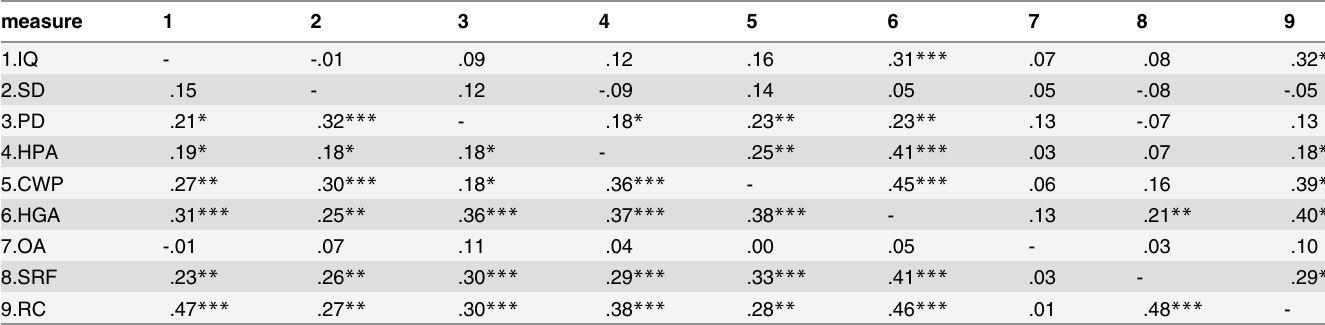
Table 3. Correlations for Observed Variables for Grades 3 and 4.